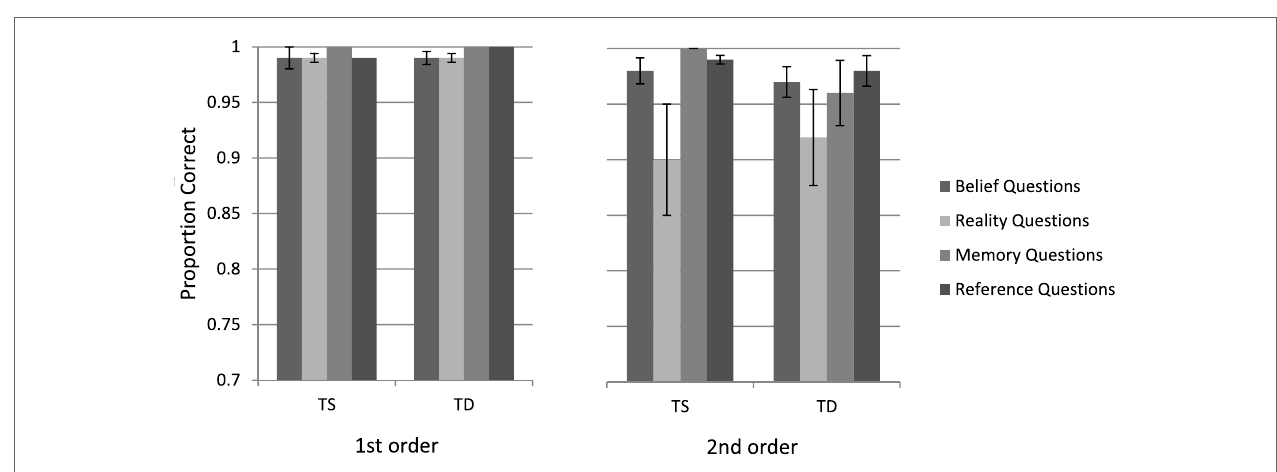
FigUre 2 | Turner syndrome (TS) and typically developing (TD) groups performance in the false belief task (first-order, second-order questions).